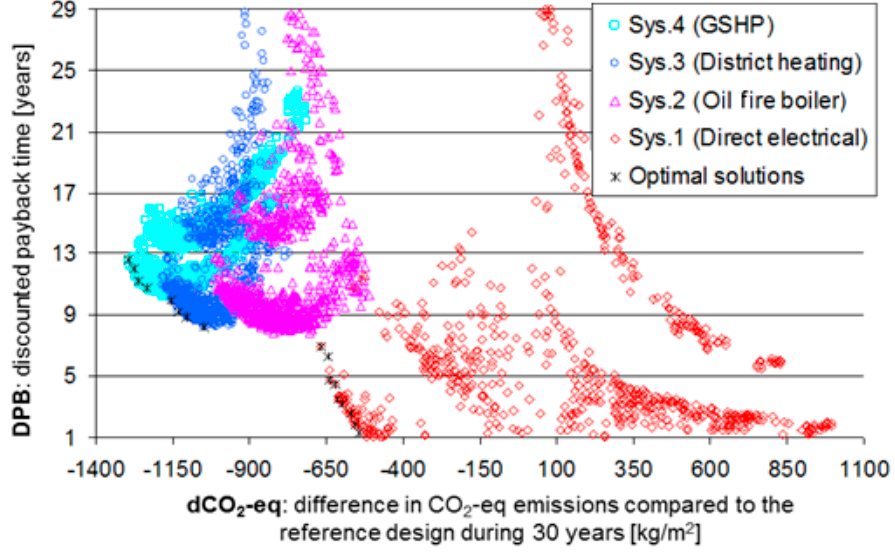
Figure 7. The results of Case 2.